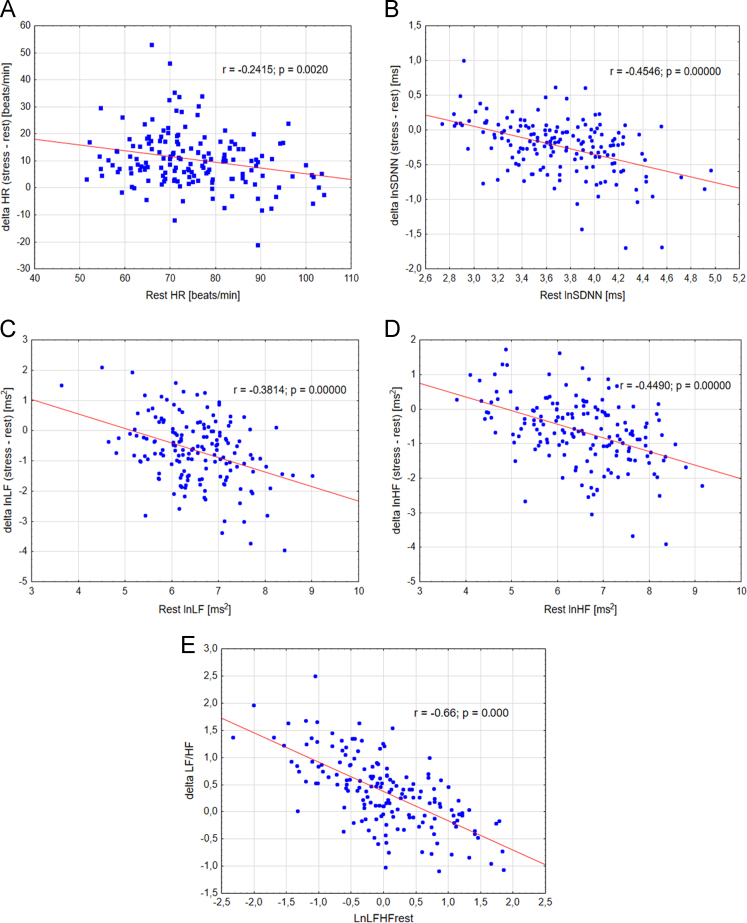
Change (stress–baseline) is highly correlated with baseline HRV levels. Scatter plots of baseline HR (A), lnSDNN (B), lnLF (C), and lnHF (D) vs. change. All linear regressions demonstrated a significant inverse correlation.